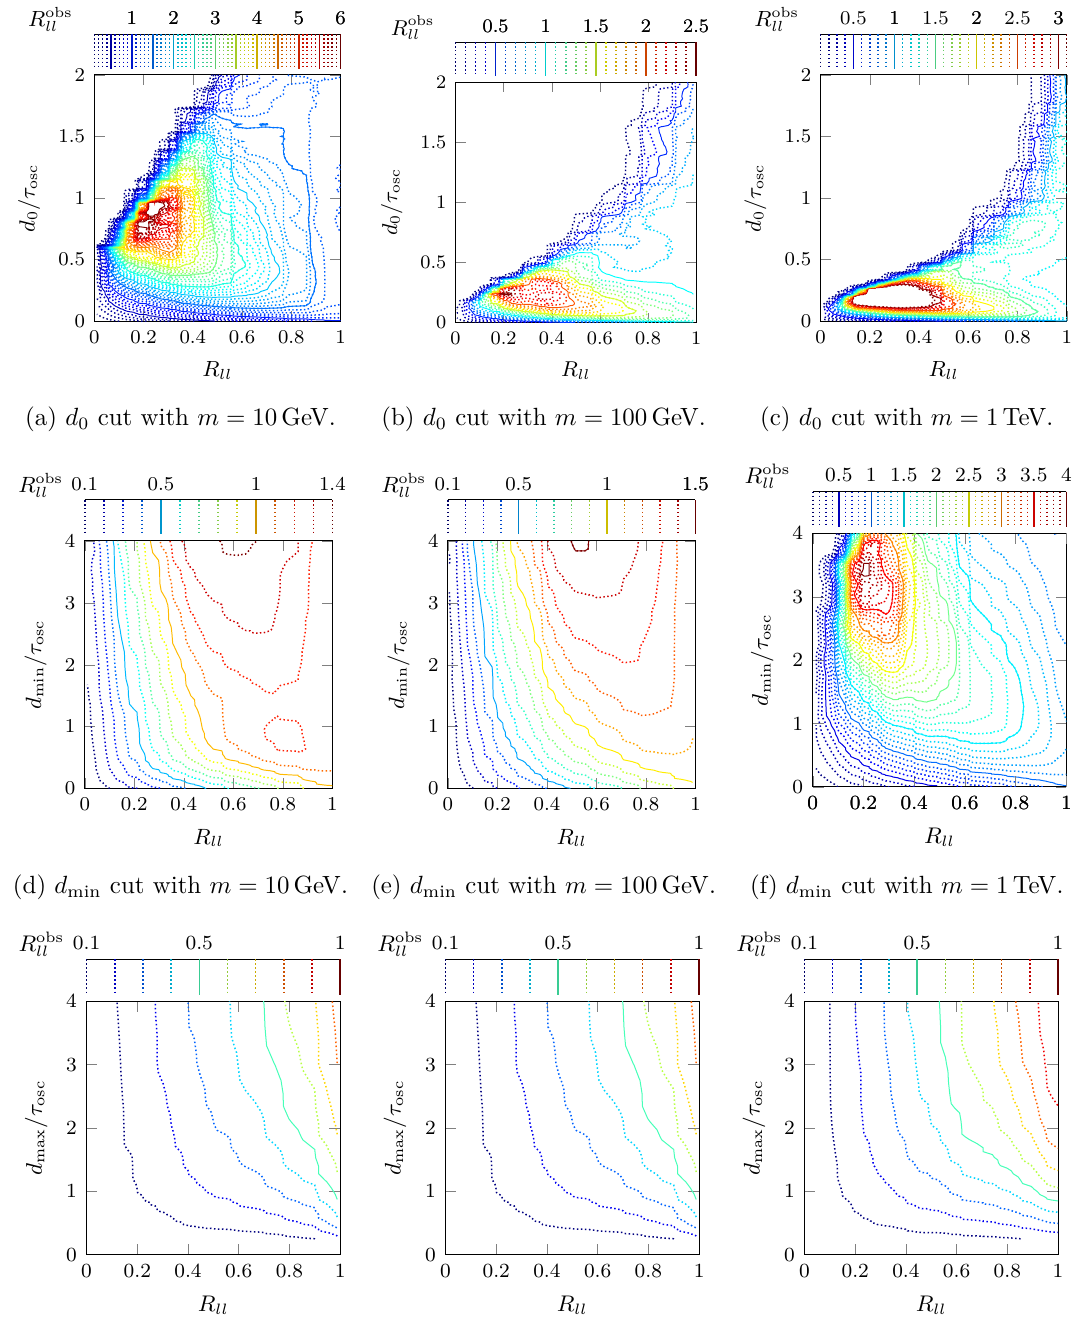
Figure 16 . Simulation of R ll under consideration of a finite d 0 in panels (a), (b), and (c), of a finite d min in panels (d), (e), and (f) as well as of a finite d min in panels (g), (h), and (i). Each cut is shown for three different masses m = 10 , 100 , 1000 GeV